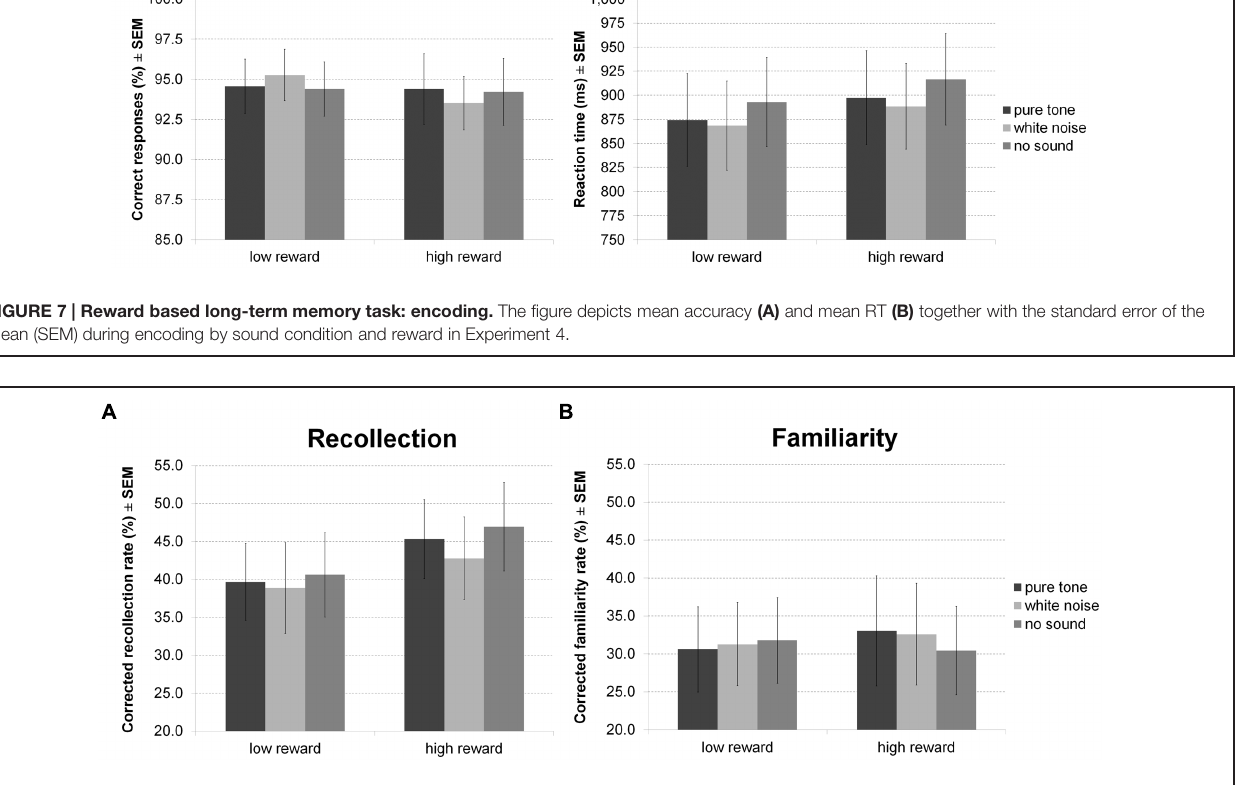
FIGURE 8 | Reward based long-term memory task: recognition. The figure depicts mean corrected hit rates together with the standard error of the mean (SEM) during recognition by sound condition, reward, and memory process in Experiment